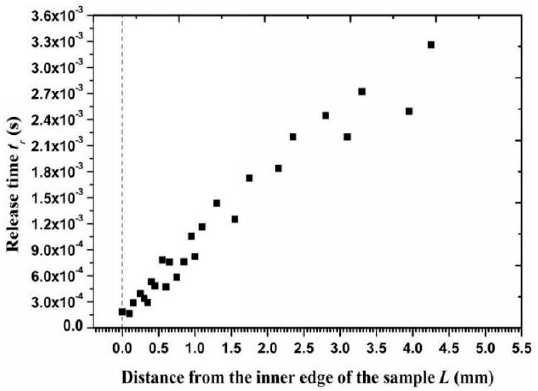
Figure 11. Depths for an erosion crater obtained by experimental measurement and numerical calculation, ( a ) SEM micrograph of the single impact crater on the outer circumference surface; ( b ) erosion depth caused by independent particle impacts and cluster impacts versus experimental results.